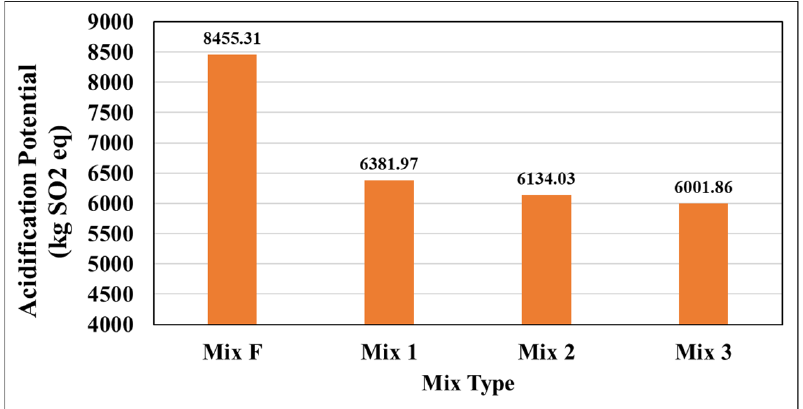
Figure 9. Acidification Potential (AP) by mix type.